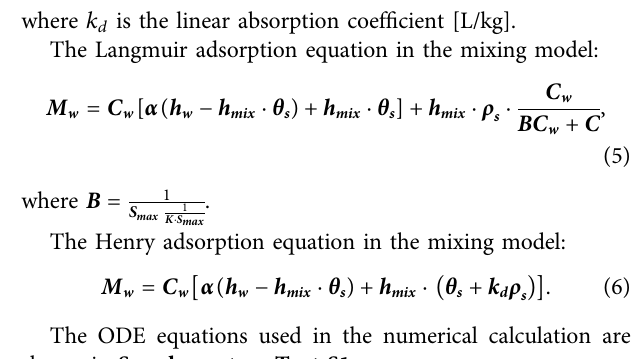
Frontiers in Environmental Science |